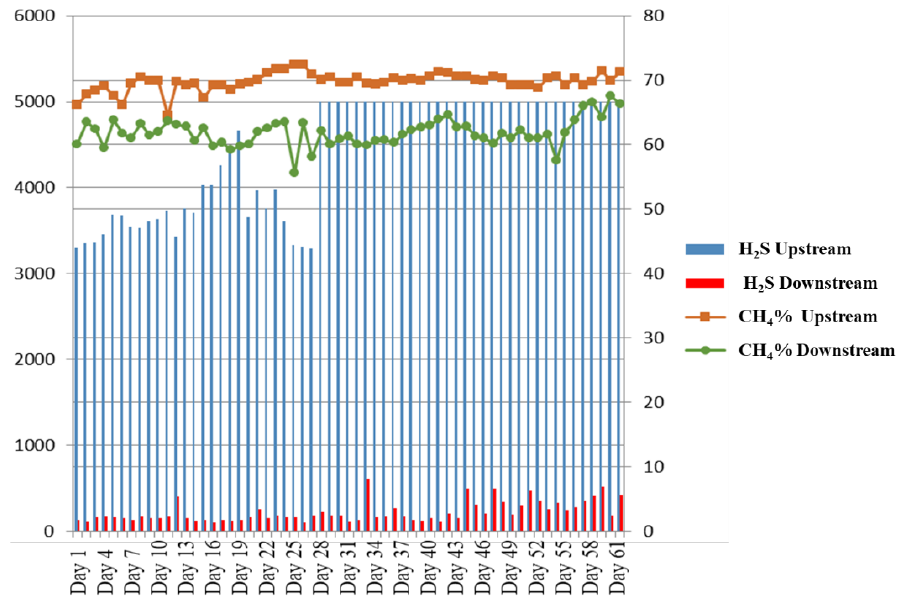
Figure 7. Graphic presentation of the biogas treatment test results on the prototype object of the invention .